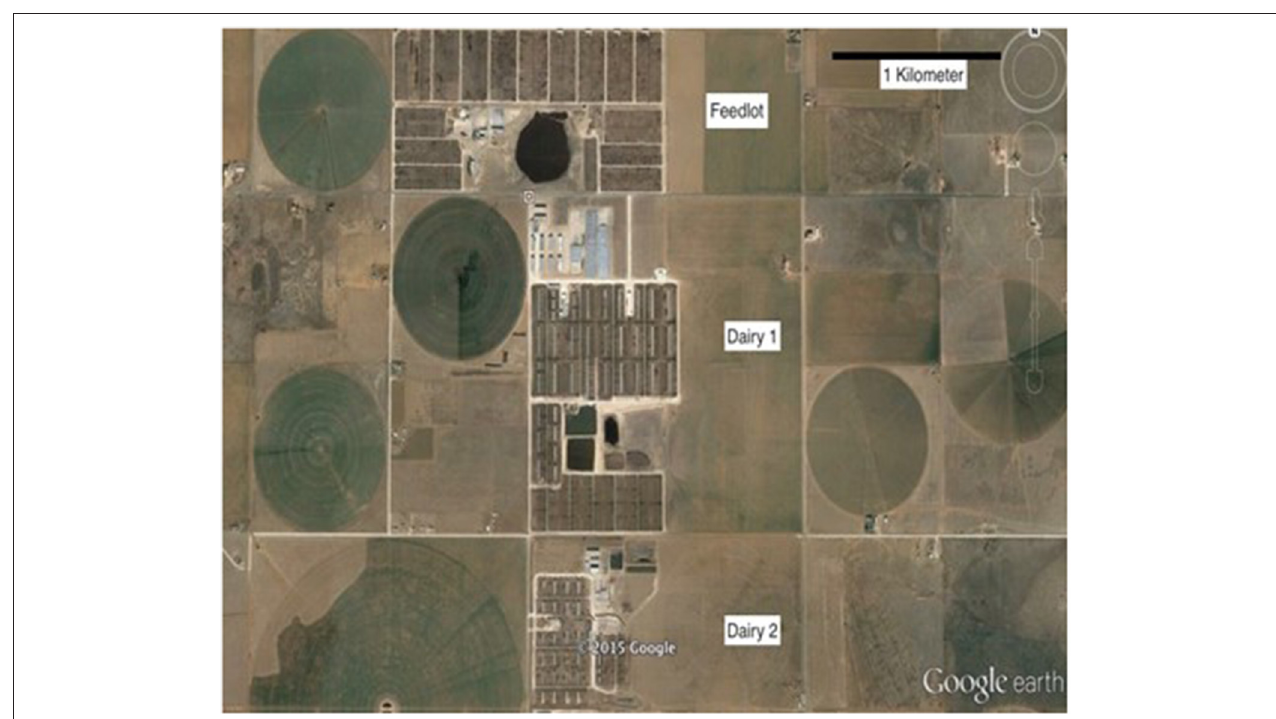
FIGURE 1 | Google earth image displaying the proximity of the three facilities sampled in the southern high plains.